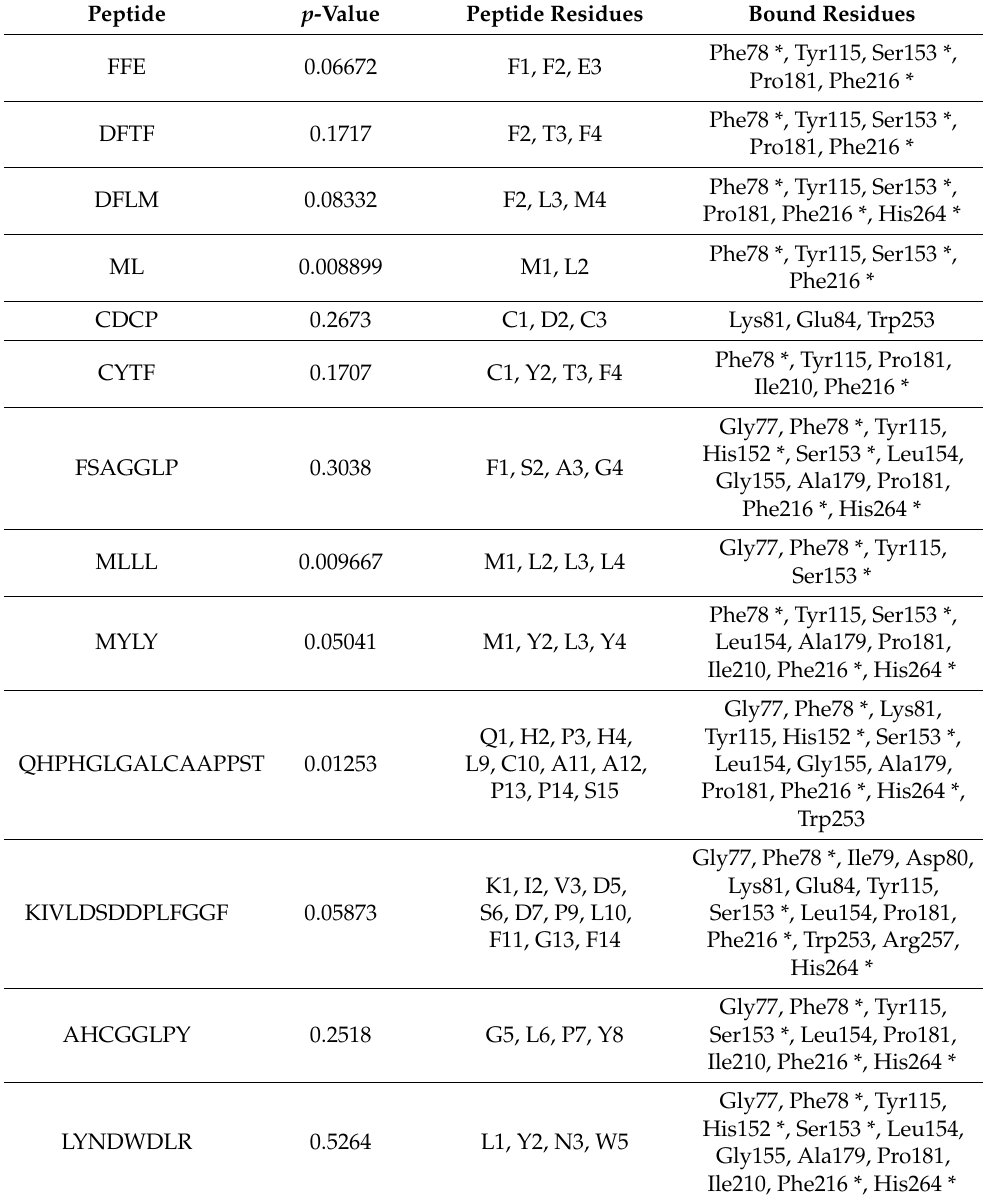
Table 3. Pepsite 2 analysis of the selected peptides using pancreatic lipase as a protein receptor. Peptide p -Value Peptide Residues Bound Residues FFE F1, F2,